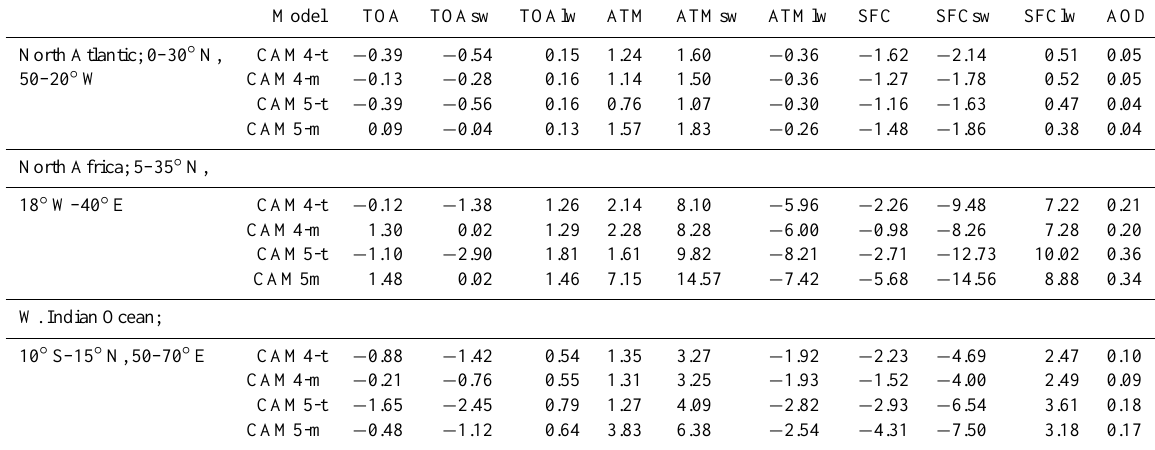
Table 8b. Simulated regional annual average global all-sky radiative